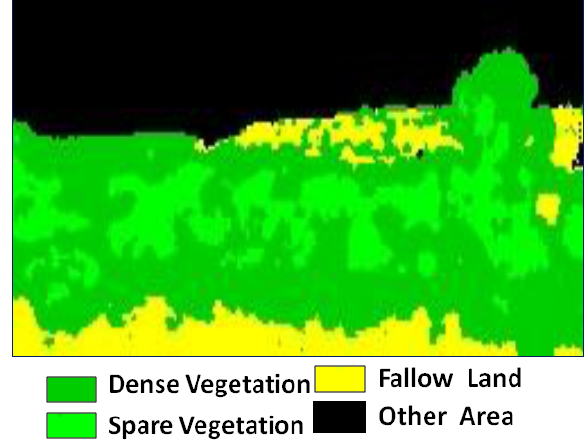
Fig.11. SAM Classifier of the Study Area